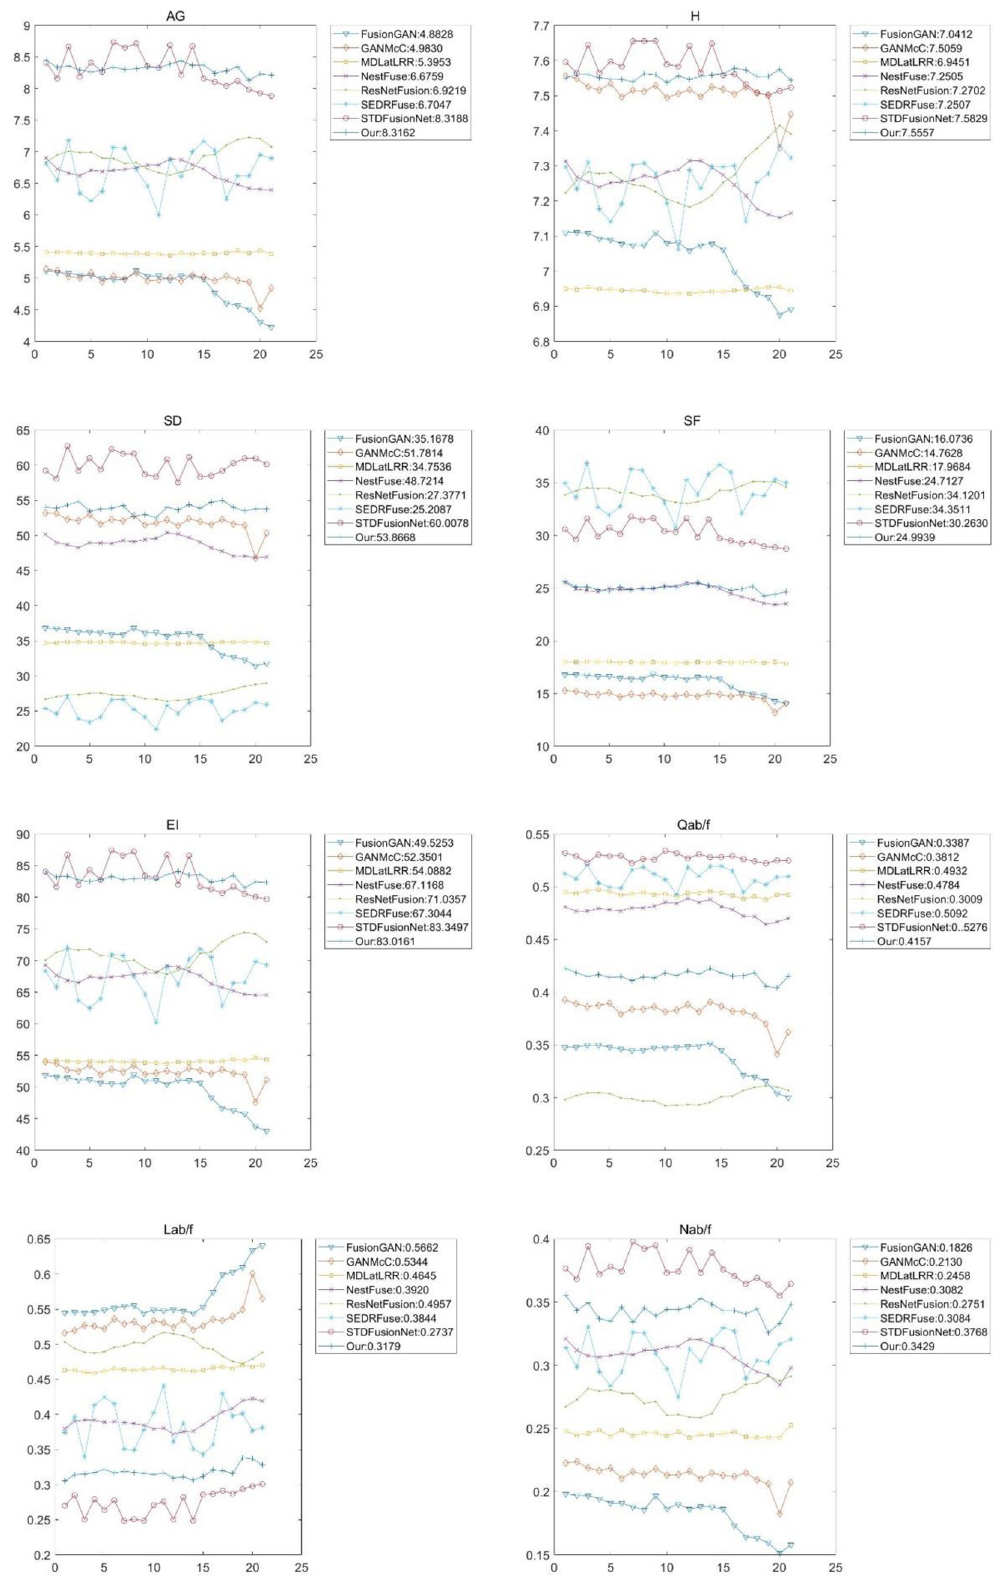
Fig 14. Quantitative comparisons in terms of the eight metrics, AG, H, SD, SF, EI, Q ab/f , L ab/f , and N ab/f , for the Nato_campsequence from the Trees and runner sequence from the INO dataset. https://doi.org/10.1371/journal.pone.0278055.g014 PLOS ONE | https://doi.org/10.1371/journal.pone.0278055 December30,